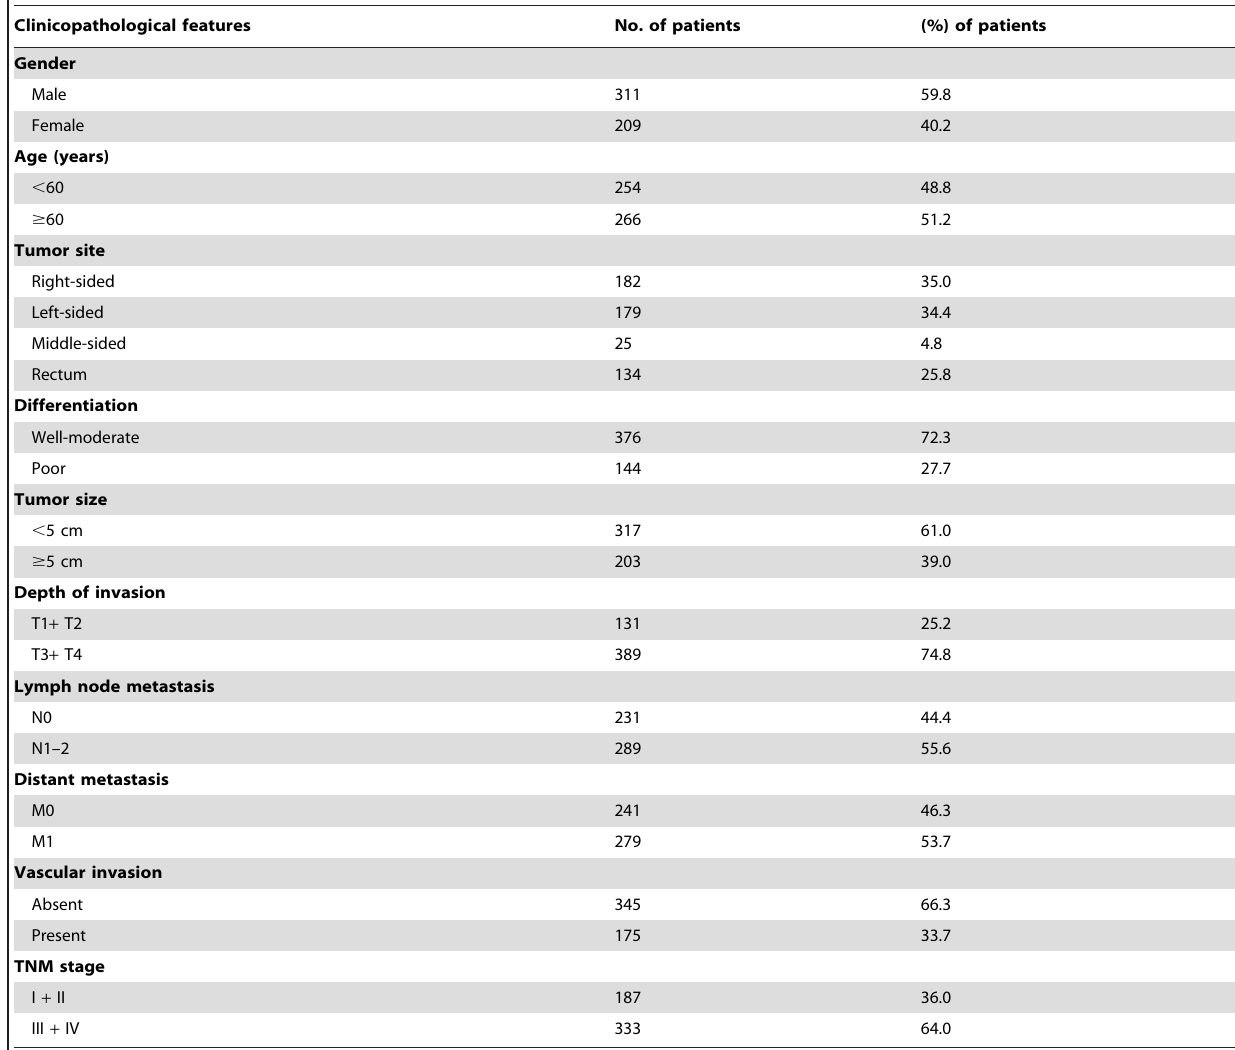
Table 1. Summary of patient characteristics